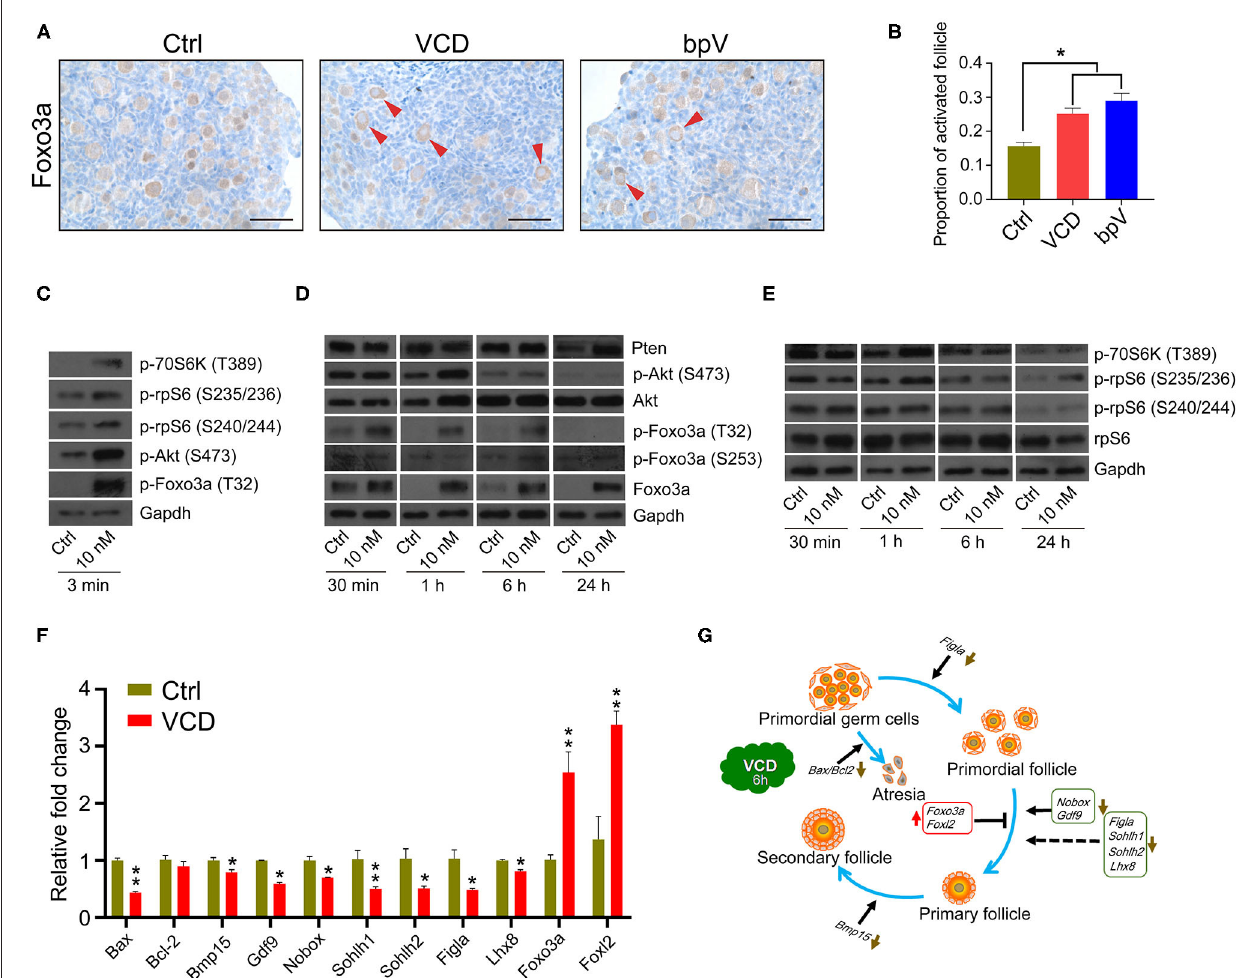
FIGURE 3 | Very short-term VCD exposure transiently activates the PI3K-Akt-mTOR pathway activity, but extended exposure causes follicular development arrest. (A) Immunohistochemical staining of Foxo3a in cultured PD2 ovaries with or without VCD (10nM) for 6h. The Pten inhibitor bpV (100 µ M) was added as a control. Scale bar = 50 µ m. (B) Counting ratio of Foxo3a nuclear exclusion after 6h of ovarian culture. * indicates p < 0.05; Student’s t -test. The data are presented as the mean ± S.D. of n = 6 biological replicates per group, and four tissue sections were counted per ovary. (C) Immunoblotting of phosphorylation levels for several proteins (P70S6k at Thr389, rpS6 at Ser235/236, rpS6 at Ser240/244, Foxo3a at Thr32, and Akt at Ser473) in cultured PD2 ovaries immediately after VCD exposure (3min). Gapdh was used as the loading control. Representative blot images are shown, n = 3 biological replicates per group. (D) Immunoblotting of proteins of the PI3K-Akt-Foxo3a pathway (Foxo3a at Thr32, Foxo3a at Ser253, Foxo3a, Akt at Ser473, Akt, and Pten) in cultured PD2 ovaries exposed to 10nM VCD for different times. Gapdh was used as the loading control. Representative blot images are shown, n = 3 biological replicates per group. (E) Immunoblotting of proteins of the mTOR pathway (P70S6k at Thr389, rpS6 at Ser235/236, rpS6 at Ser240/244, and rpS6) in cultured PD2 ovaries exposed to 10nM VCD for different times. Gapdh was used as the loading control. Representative blot images are shown, n = 3 biological replicates per group. (F) qPCR expression analysis of genes related to early follicle development in cultured PD2 ovary samples treated with VCD (10nM) for 6h. * indicates p < 0.05 and ** indicates p < 0.01 by Student’s t -test, n = 3 biological replicates per group. (G) Diagram showing changes in the levels of selected transcription factors related to early follicle development after 6h of VCD